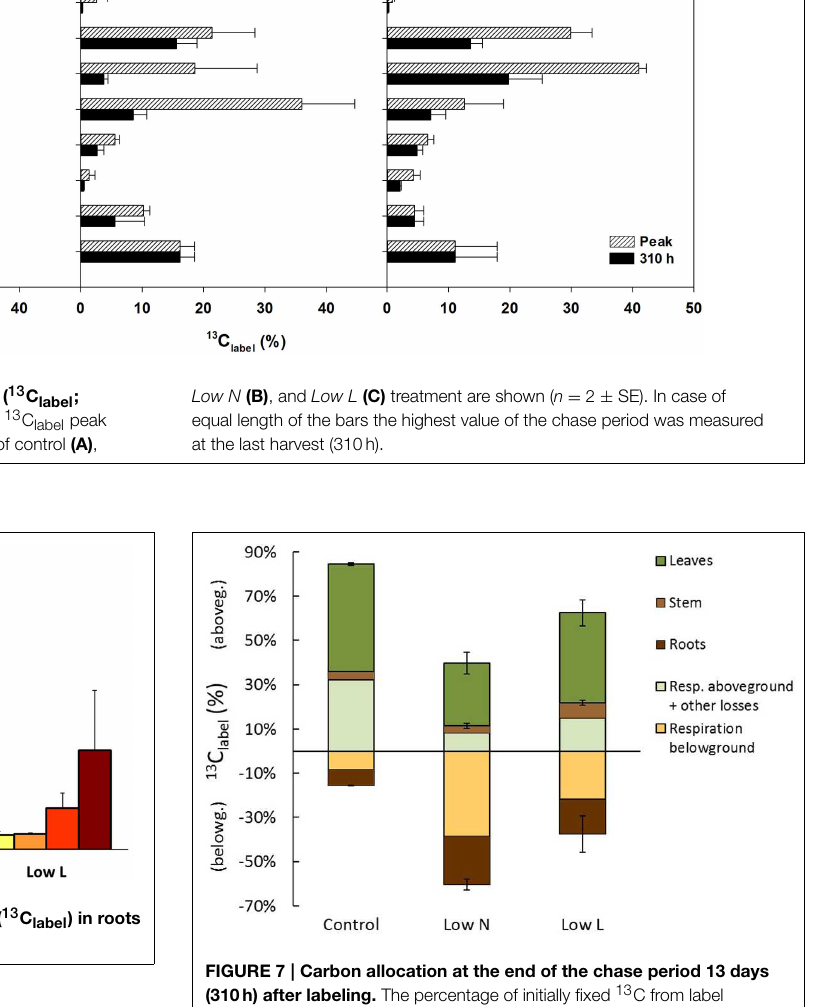
vs. lateral stems). Thus, our results show that the